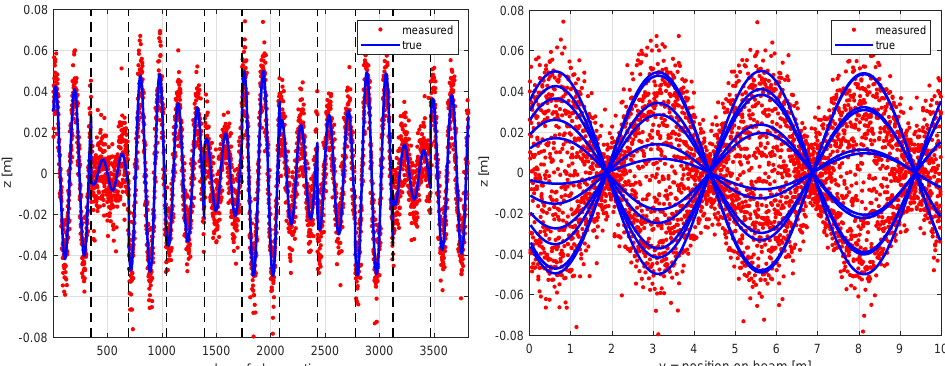
Figure 2. Measured points (red dots), simulated oscillation (blue lines) in basic set-up along the number of measurements ( left , vertical black dashed lines indicate new profile) and along the position on the beam ( right